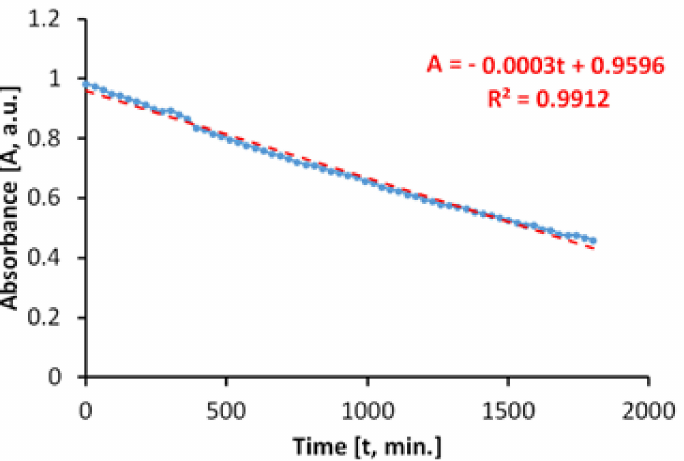
Figure 11. Time variation of MB absorbance during irradiation exclusively with visible light, in the absence of the photocatalytic